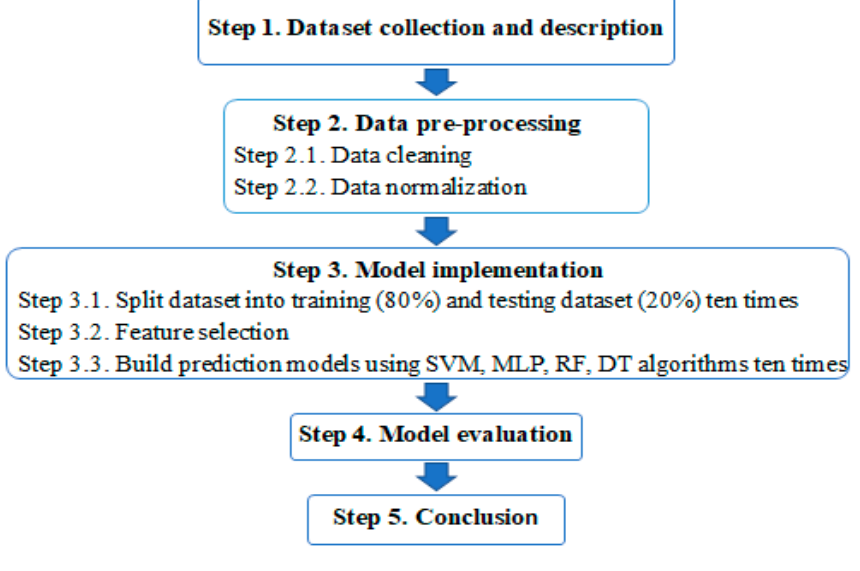
Figure 1. Experimental process.